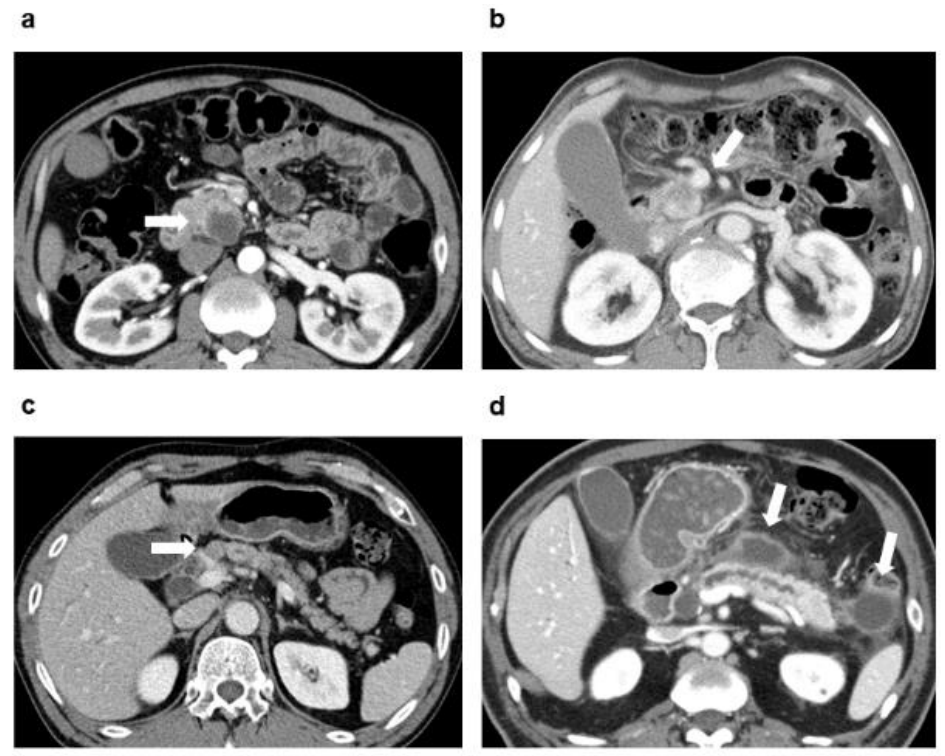
Figure 2. Four preoperative imaging characteristics included in the nomogram to predict one- and five-year DFS and OS in patients with pancreatic head cancer who underwent curative-intent surgery without neoadjuvant therapy. Presence of ( a ) necrosis (centrally located cystic change of the tumor with irregular internal margin), ( b ) worrisome finding for invasion of PV or SMV according to the NCCN guidelines, ( c ) suspected metastatic regional lymph node (short diameter > 8 mm, round, irregular or necrotic change), and ( d ) associated pancreatitis or pseudocyst on CT. DFS, disease-free survival; OS, overall survival; PV, portal vein; SMV, superior mesenteric vein; NCCN, National Comprehensive Cancer Network; CT, computed tomography.